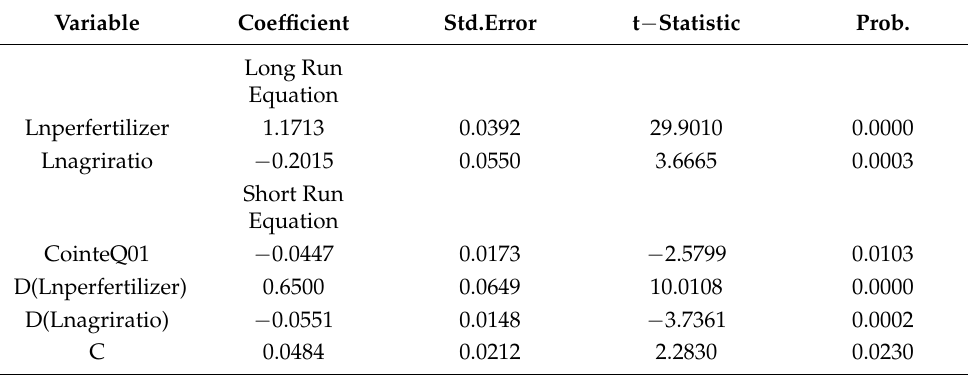
Table 6. The results of ARDL analysis.